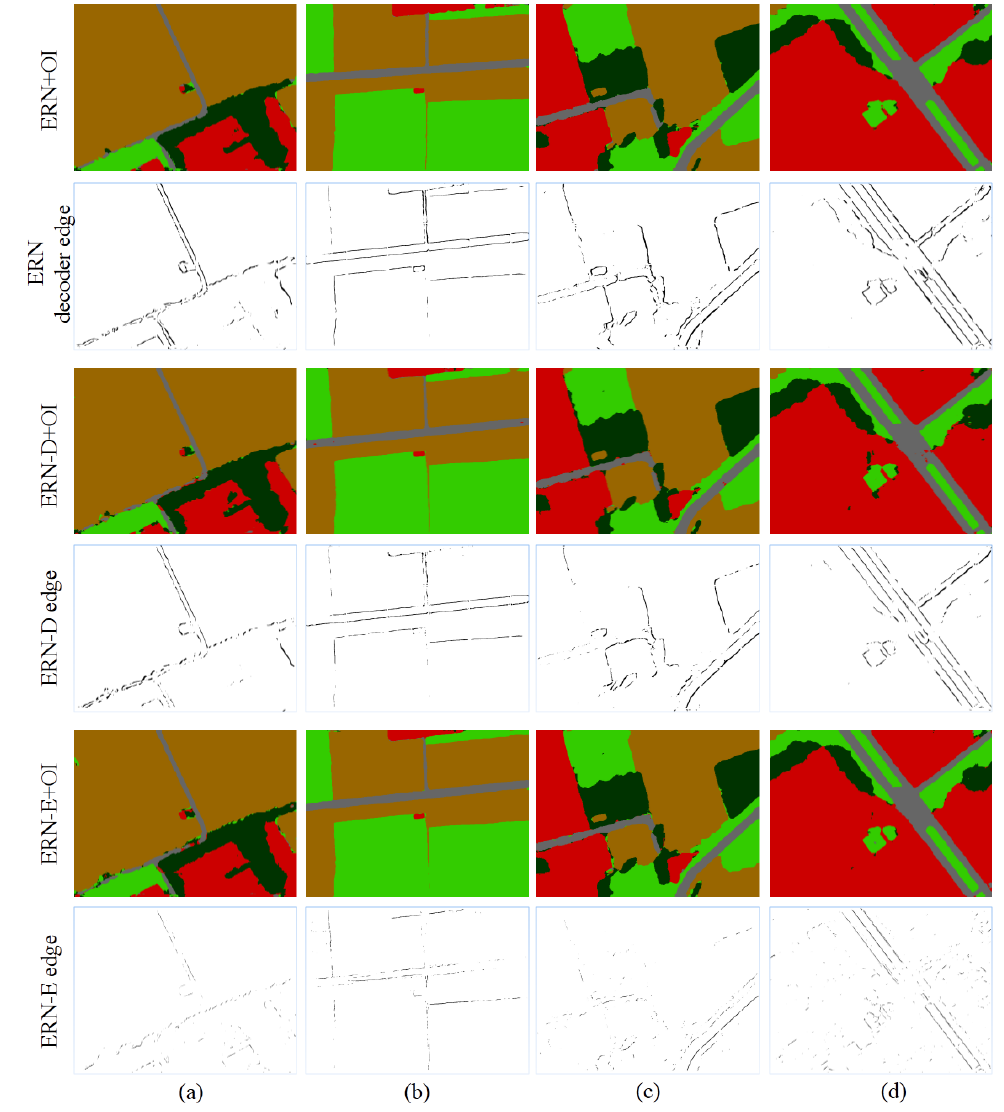
Figure 12. The results of semantic predictions and edge predictions. ERN ( α 1 = 1, α 2 = α 3 = 10), ERN-D ( α de = 10), ERN-E ( α en = 10). ( a – d ) are four different scenes from the UAV image